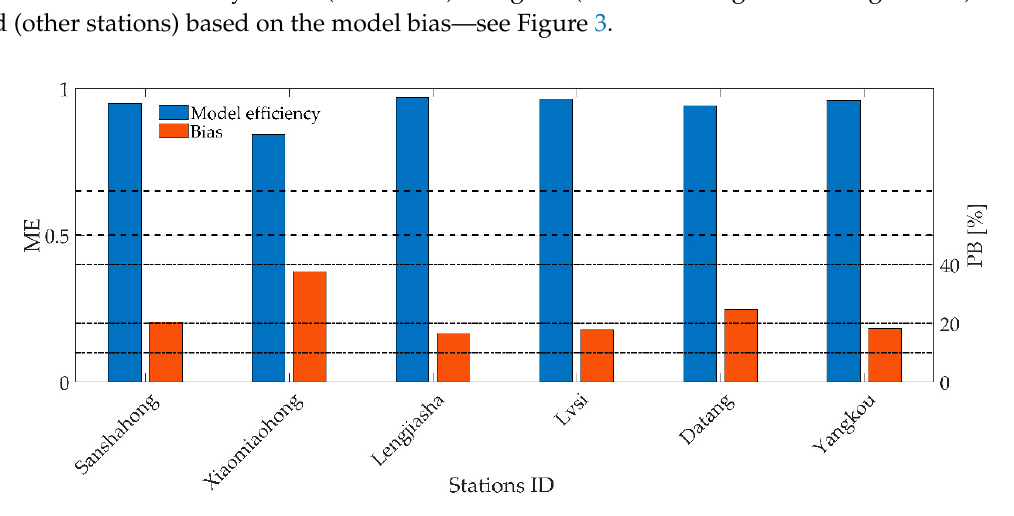
Figure 3. Model E ffi ciency and Percentage Bias for the calculated waterlevels at the six tidal Figure 3. Model Efficiency and Percentage Bias for the calculated waterlevels at the six tidal gauges.